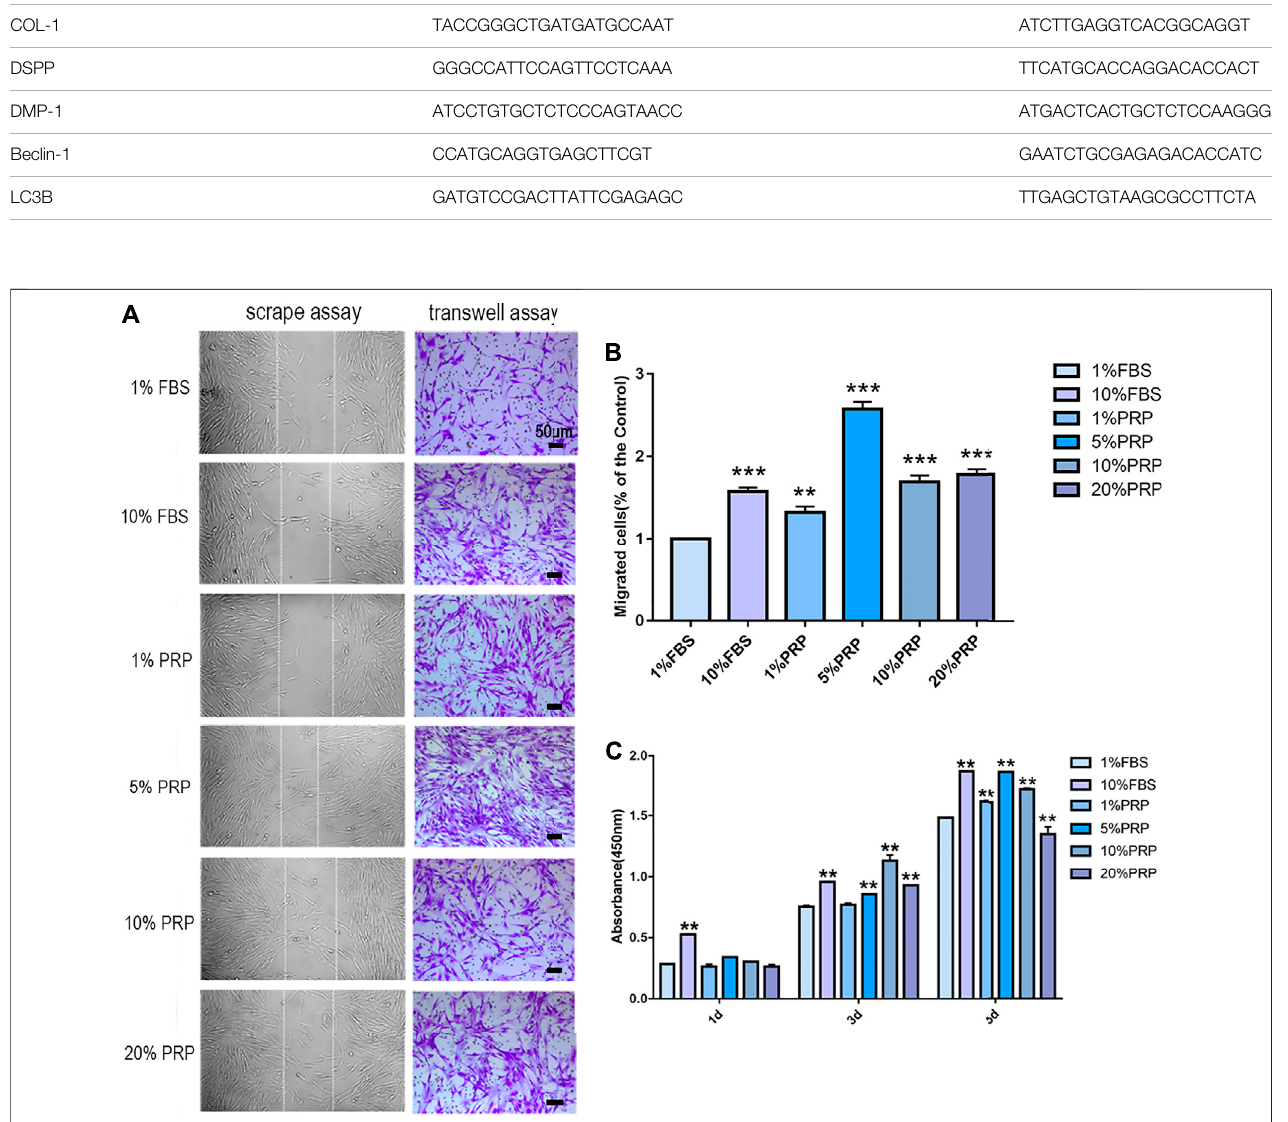
FIGURE1| PRPenhancedcellmigrationandproliferationofhDPCs. (A) Inscrapeassay,hDPCswereseededinto6-wellplatesinthepresenceof1and10%FBS and 1, 5, 10, and 20% PRP for 24 h. In transwell assay, hDPCs were seeded into the upper chamber of transwell plates, with different concentrations of FBS or PRP in thelowerchamberfor24 h(scalebar,50 μ m). (B) MeasurementofthenumberofmigratedhDPCsinatranswellassay. (C) TheproliferationofhDPCswasassessedbya CCK-8 assay. Data in (B) and (C) are representative of three independent experiments. Data are presented as mean ± standard deviation. Signi fi cantly different groups, * p < 0.05, ** p <